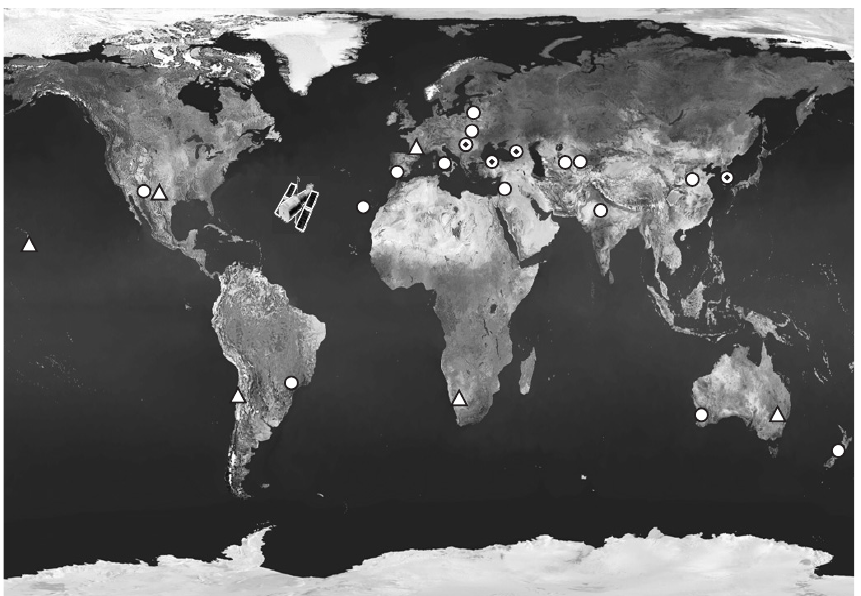
Fig. 2. The distribution of participating WET observatories around the world. The triangles are the six pioneer observatories, the open circles are observatories that have later participated, and the open circles with dots are the newcomers, not yet fully certified as WET observatories. The Hubble Space Telescope is also shown as it participated in XCovs 16, 17, 19 and